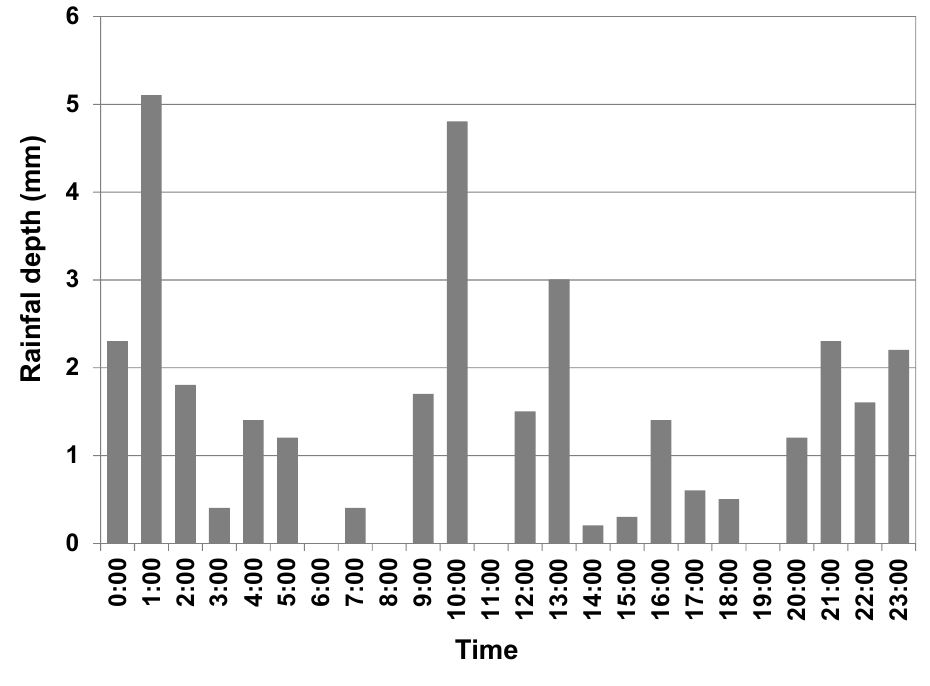
Figure 4. Recorded hyetograph on 26 July